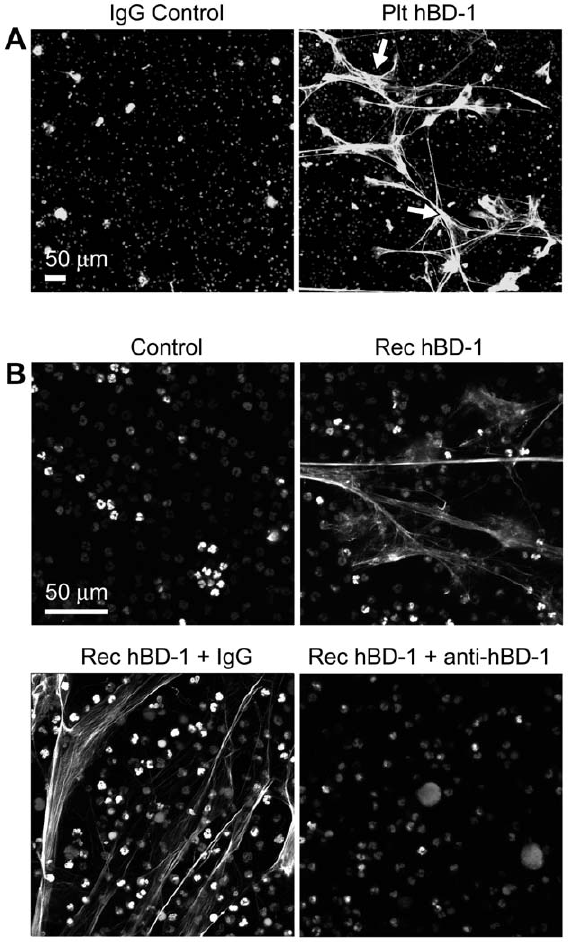
Figure 5. b -defensin 1 induces NET formation by PMNs. (A) NET formation in the presence of control immunoglobulin (left panel) or hBD-1 (right panel) immunoprecipitates that were captured from human platelets. The NETs (arrows) were detected by live cell imaging as previously described[16]. (B) NET formation in untreated PMNs (control) or PMNs incubated with 100 ng/ml of recombinant hBD-1 alone or in the presence of anti-hBD-1 or its control IgG. Figure 5A and 5B are representative of three independent experiments.